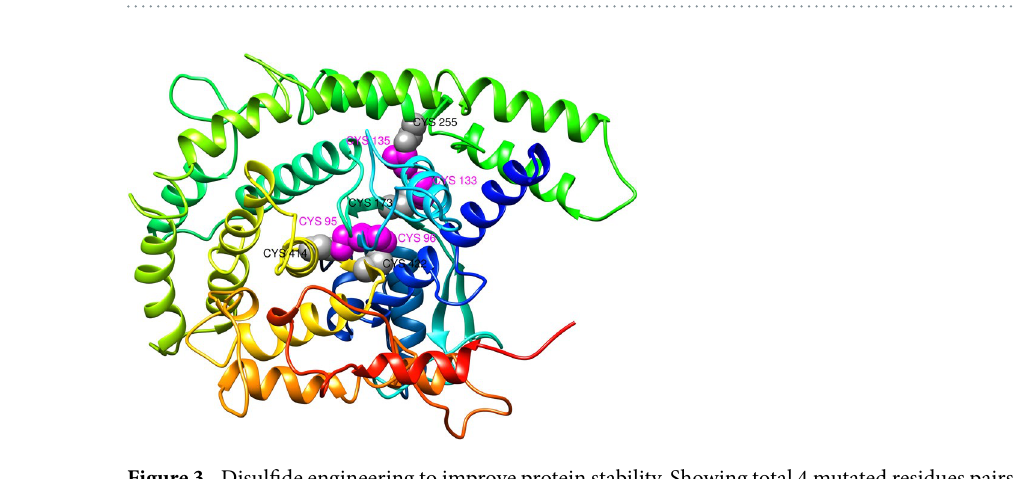
Figure 2. Tertiary structure prediction and validation of vaccine construct. ( A ) Tertiary structure predicted for the primary sequence of subunit vaccine construct showing helix, sheet and coiled region. ( B ) Ramachandran plot formation to validate the 3D modeled structure showing 92.4% residues in the favored region.